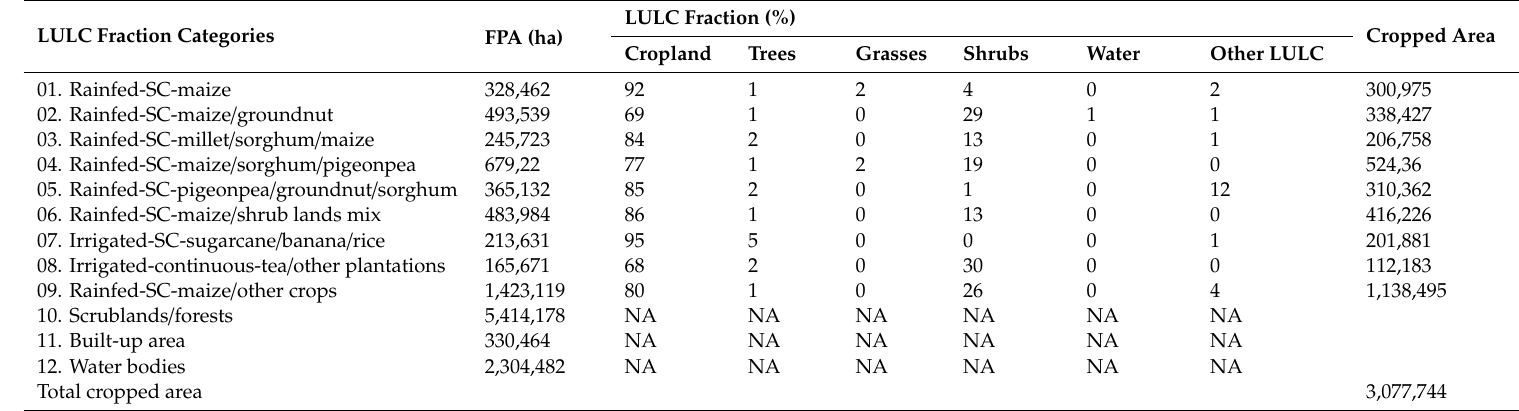
Table 4. Cropland area for each class, providing an understanding of sub-pixel fractions for the 12 final classes in Malawi for the crop year 2010–2011. LULC Fraction Categories